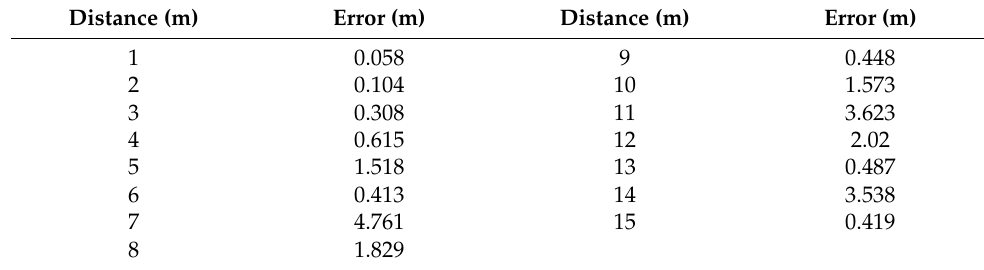
Table 2. Ranging error within 15 m at 1 m